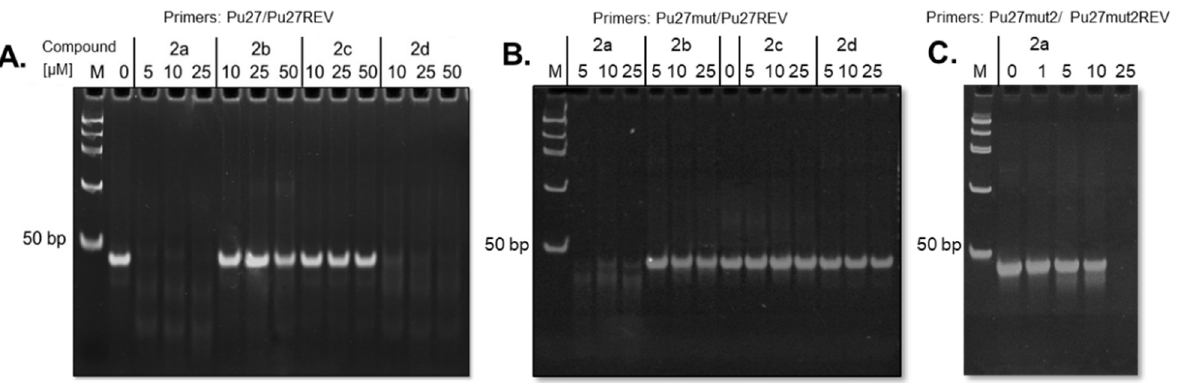
Figure 3. Polyacrylamide gels stained with ethidium bromide showing the effect of compounds on polymerization of DNA constructs. ( A ) Compounds 2a – d in presence of c-MYC promoter wild-type sequence (Pu27); ( B ) compounds 2a – d in presence of c-MYC promoter sequence mutated in G-tract 3 (Pu27mut); ( C ) increasing concentrations of compound 2a in presence of c-MYC promoter sequence mutated in G-tracts 3 and 5 (Pu27mut2). In absence of compound (0 μ M), the 43 bp PCR product is formed. M: PCR molecular weight marker.